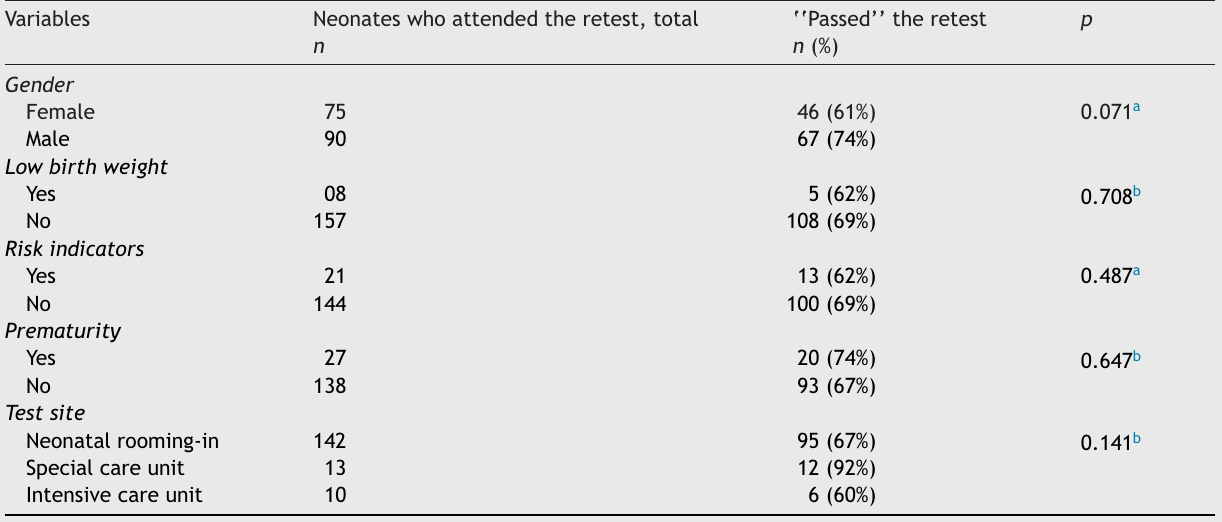
Relationship between ‘‘to pass’’ the retest on the right ear and the following variables: gender, low birth weight, risk factors, prematurity and test